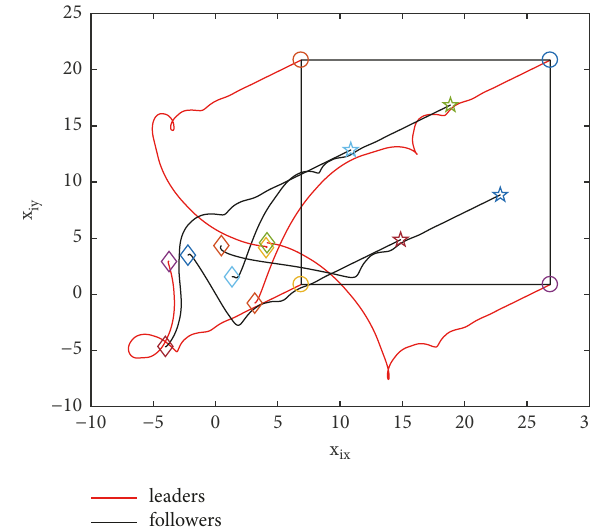
Figure 7: The positions of eight agents.